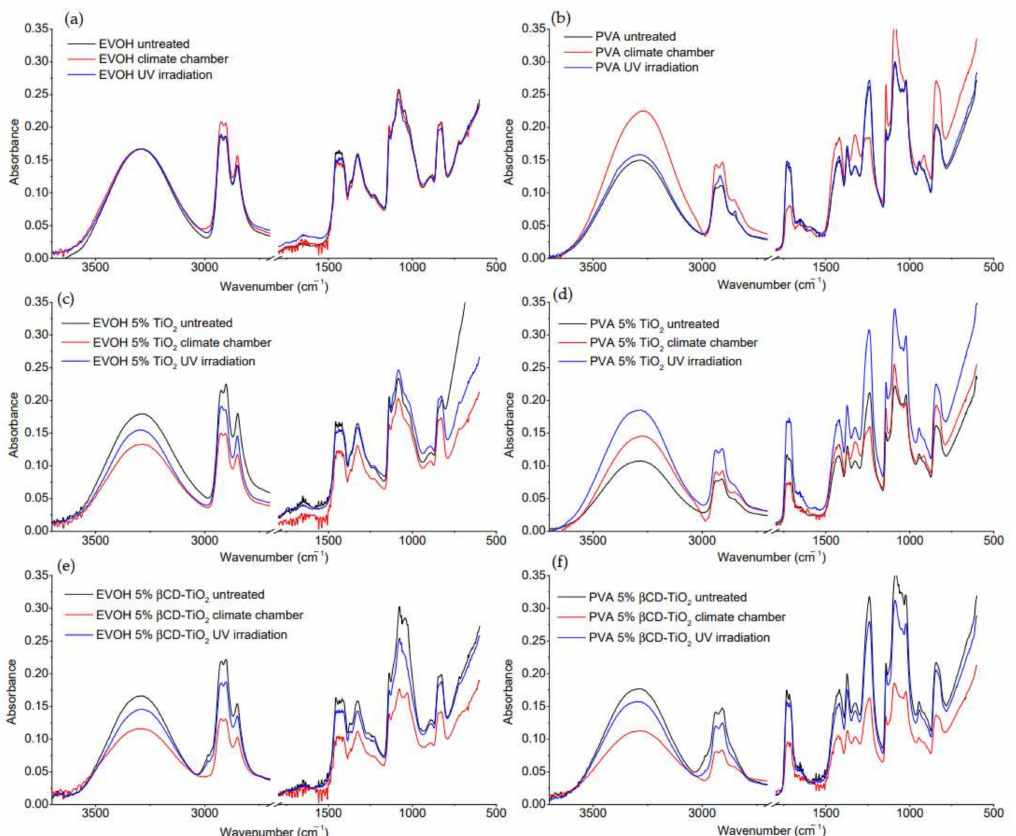
Figure 4. FTIR spectra of films containing ( a ) EVOH, ( c ) EVOH 5% TiO 2 composites, ( e ) EVOH 5% β CD-TiO 2 composites, ( b ) PVA, ( d ) PVA 5% TiO 2 composites, and ( f ) PVA 5% β CD-TiO 2 composites before and after treatment in a stability chamber (80 ◦ C and 80% relative humidity) and UV light irradiation (365 nm) over 24